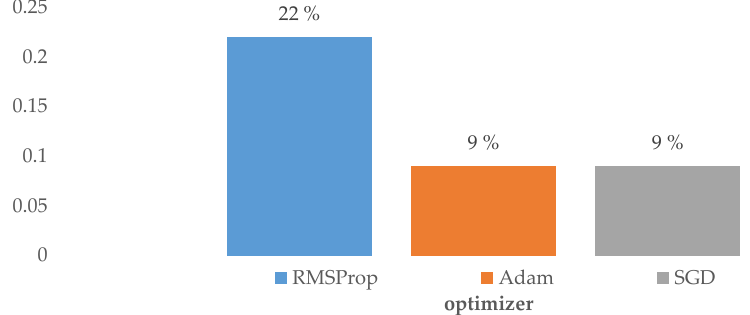
Figure 6. Impact of the dropout value in the custom model in terms of HTER (the lower the better).